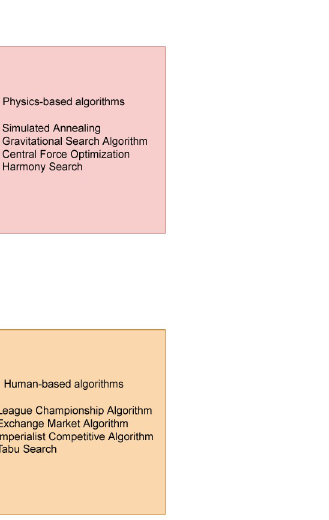
Fig 1. Various categories of nature-inspired meta-heuristic